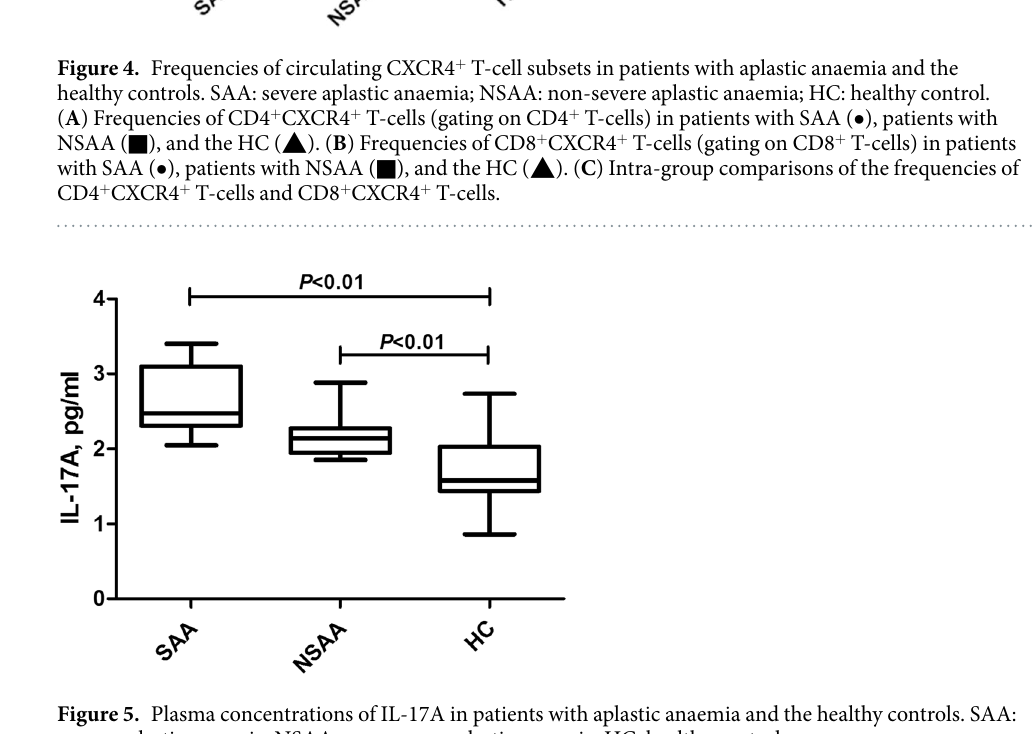
Correlation analysis. The percentage of CD4 + CXCR4 + T-cells was positively correlated with plasma IL-17A concentrations ( r = 0.296, P = 0.028, Fig. 6A), but was negatively correlated with absolute neutrophil counts ( r = –0.275, P = 0.007, Fig. 6B). The percentage of CD8 + CXCR4 + T-cells was negatively correlated with absolute neutrophil counts ( r = − 0.251, P = 0.015, Fig. 6C). The CD4 + /CD8 + T-cell ratio was negatively correlated with plasma IL-17A concentrations ( r = − 0.311, P = 0.005, Fig. 6D), but was positively correlated with haemoglo- bin concentrations ( r = 0.387, P = 0.001, Fig. 6E), platelet counts ( r = 0.401, P = 0.001, Fig. 6F), and absolute